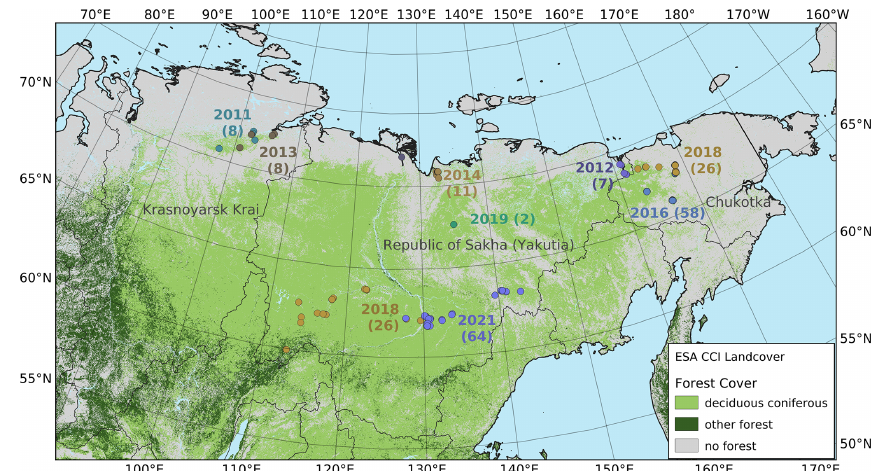
Figure 1. The vegetation in the larch-dominated forests of northeastern Russia. Numbers indicate the year and the number of vegetation plots on each expedition.